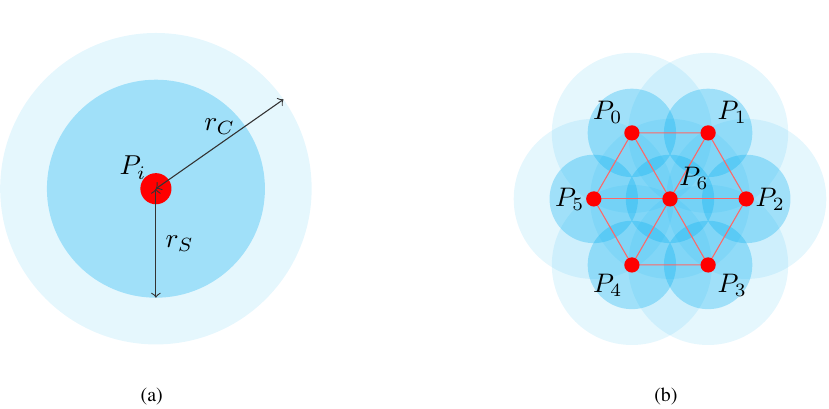
Fig. 1: (a) Sensor P i with its sensing r S and communication r C ranges. (b) The set of neighboring sensors of the sensor P 6